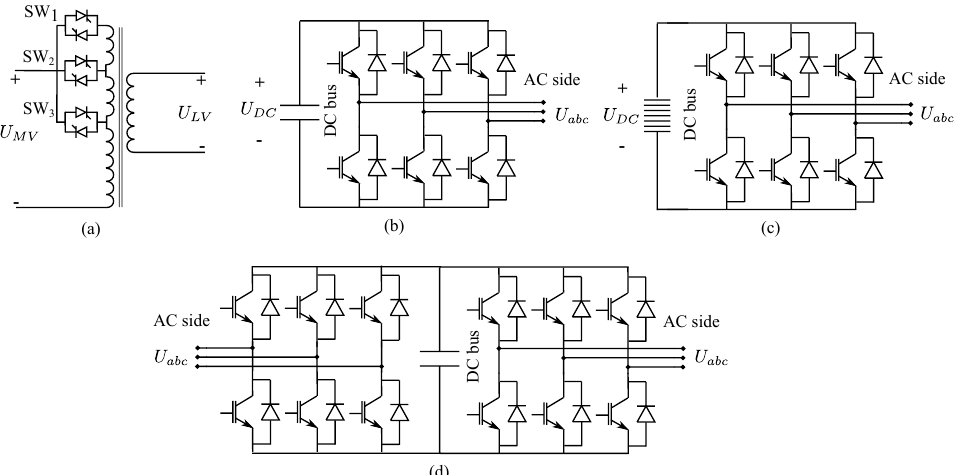
Figure 4. Power electronic devices incorporated in the smart grid distribution system: ( a ) solid state tap changer (SSTC); ( b ) three-phase, three-wire STATCOM; ( c ) three-phase, three-wire BESS; and ( d ) DC link composed of two back-to-back